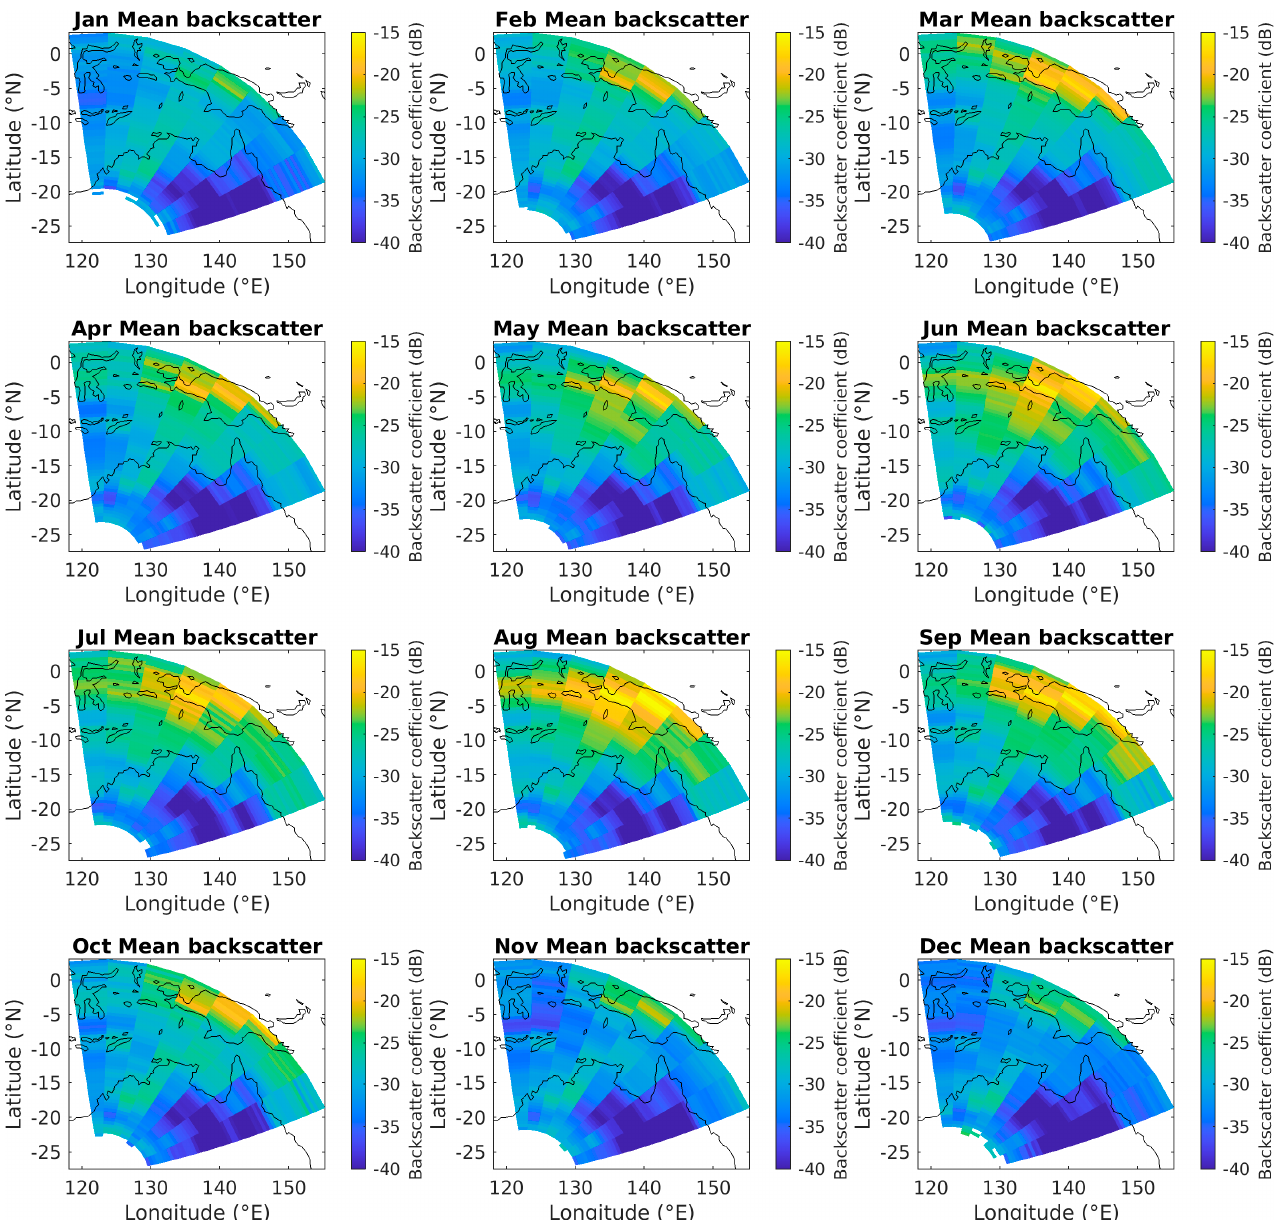
Figure 18. Decade mean of the monthly backscatter coefficients for LAE.